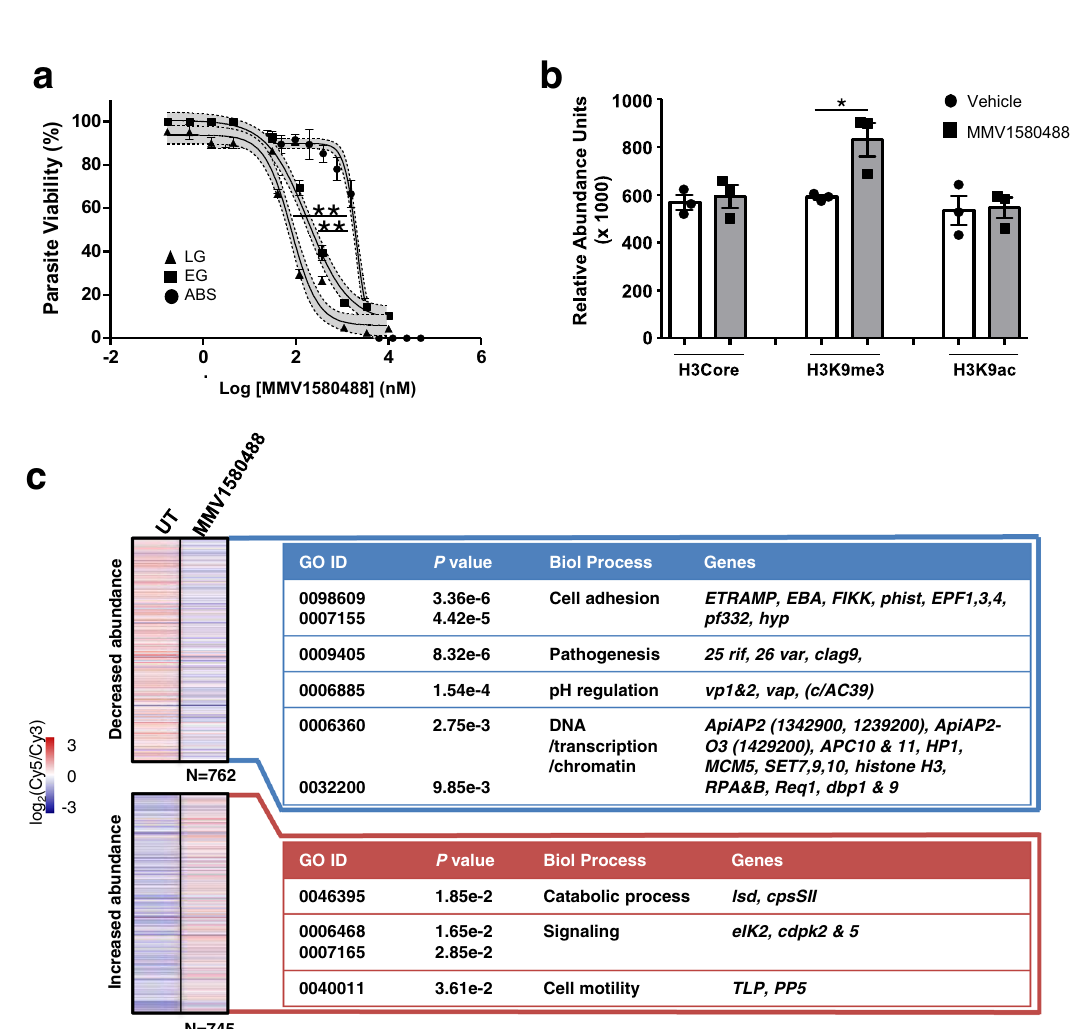
Fig. 5 Transmission-blocking activity of active compounds from the PRB against P. falciparum stage IV/V gametocytes, gametes and oocysts. a Chemical cluster analysis of the gametocyte hit compounds, using the FragFP descriptor and a Tanimoto similarity index >0.50 in OSIRIS DataWarrior v 5.0.0, and network construction with Cytoscape v 3.7.2. Edges were assigned between similar scaffolds and a parent node. Active compounds with IC 50 values <2 µ M are indicated in green, those with additional activity at the same cut-off on ABS are indicated with hexagons and those with shared activity on liver stages with black borders. Structures are highlighted for selected compounds. Data are from three independent biological repeats ( n = 3), each performed in technical triplicates, ±S.E. b Nineteen compounds with activity against P. falciparum stage IV/V gametocytes were evaluated for their ability to inhibit male gamete ex fl agellation. Compounds (2 µ M) were used on stage IV/V gametocytes for a 48-h treatment prior to inducing male gamete ex fl agellation (carry-over format). Data are from three independent biological repeats ( n = 3), performed in technical triplicates, mean ± S.E indicated, except for MMV1633967, MMV1634399 and MMV000043, for which data are from n = 2 biological repeats). Individual data points are indicated in symbols. c SMFA data for 17 compounds (selected based on >50% inhibition on male gamete ex fl agellation). SMFA was performed by feeding A. coluzzii mosquitoes with compound-treated gametocyte cultures (48 h treatment at 2 µ M). Data are presented as percentage of TRA (transmission-reducing (cid:3) 100, where i : oocyst number (intensity), C : control and T : treated) from at least three independent biological activity, reduction in oocyst intensity: Ci (cid:1) Ti Ci repeats ( n = 4), performed with technical duplicates, mean ± S.E indicated. Individual data points are indicated in symbols.